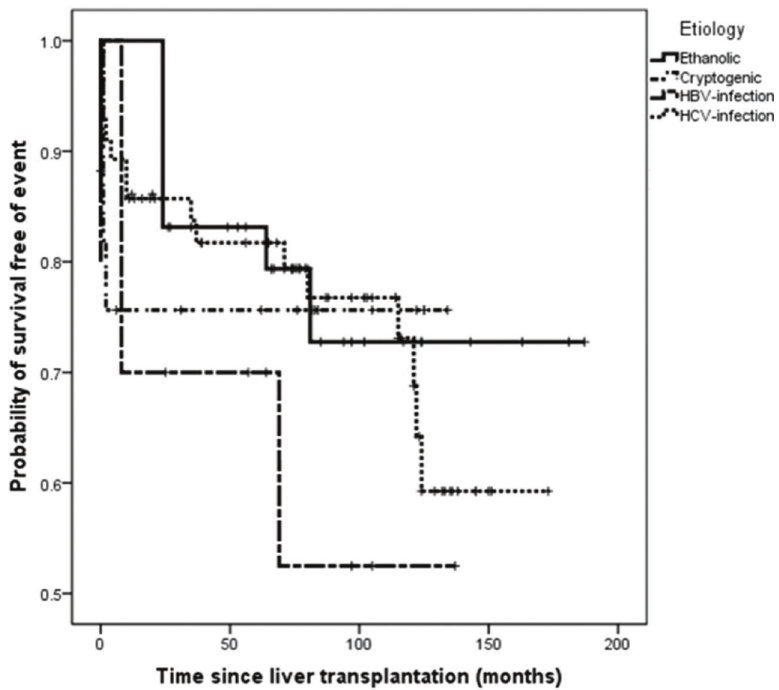
Figure 2 - Kaplan-Meier curves of event-free survival in HCC patients according to the etiologic groups of chronic liver disease.